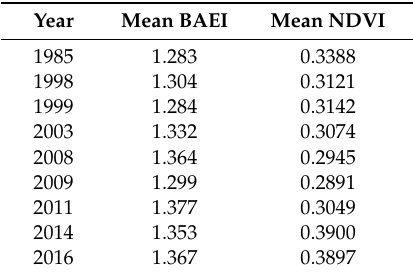
Figure 8 . Change detection time-series, giving mean index values, derived from Landsat 5 TM data; ( a ) 11/02/85 BAEI, ( b ) 11/06/98 BAEI, ( c ) 11/10/11 BAEI, ( d ) 11/02/85 NDVI, ( e ) 11/06/98 NDVI, ( f ) 11/10/11 NDVI. Table 6 . Zonal statistics of BAEI and NDVI values derived from Landsat 5 TM (1985-2011) and 8 OLI data (2014 & 2016), referencing the truncated study area.